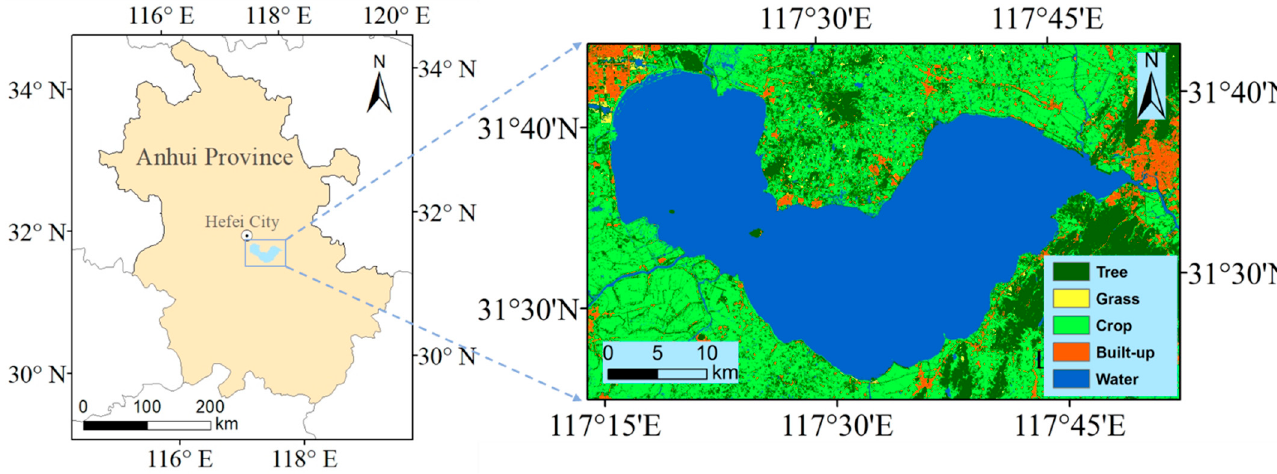
Figure 1. Map of Chaohu Lake, China.